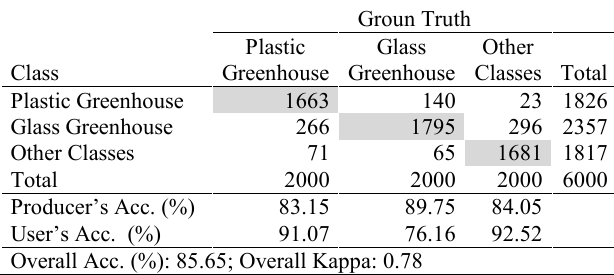
Table 1. The confusion matrix of ML classification result